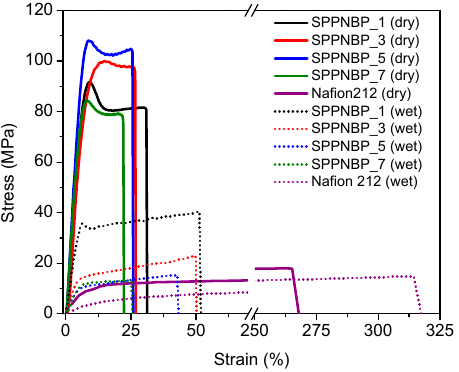
Figure 6. Strain-stress curves of SPPNBP membranes and Na fi on 212 membranes.